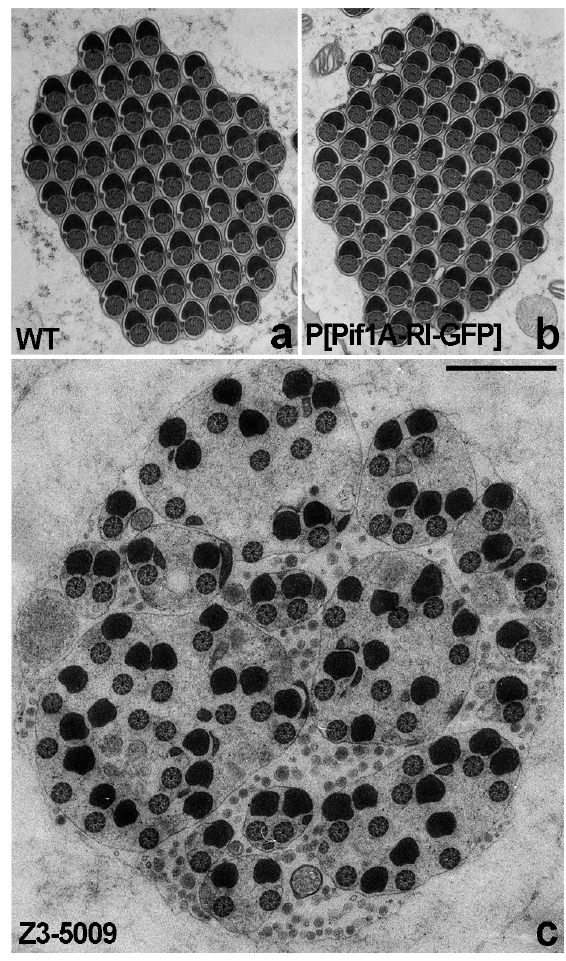
Figure 2. Individualization defects of Z3-5009 mutant visualized by electron microscopy. Cross-sectioned cysts of WT testis show individualized cysts ( a ); each of the control cysts contains pairs of axonemes and mitochondria derivatives enclosed by individual plasma membrane. Cross-sectioned cysts from Z3-5009 mutant show that individualization does not occur ( c ); numerous axonemes and mitochondria are enclosed within single membrane and surrounded by a large amount of cytoplasm, and the axonemes are not tightly juxtaposed to the mitochondria. Cross-sectioned cysts of flies that express the Pif1A-RI-GFP transgene and are homozygous for Z3-5009 (P[Pif1A-RI-GFP/CyO3; Z3-5009/Z3-5009]) show that the Z3-5009 phenotype is rescued—after individualization tightly juxtaposed axoneme/mitochondria pairs are surrounded by separate membranes ( b ). Bar 1 µm.